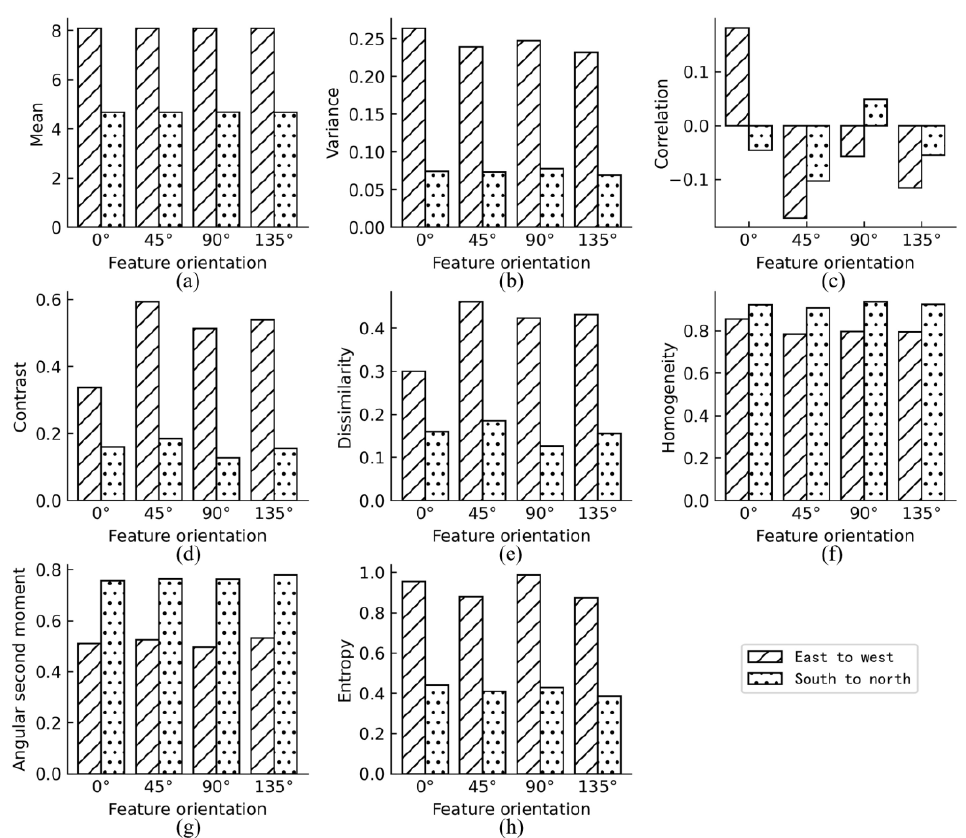
Figure 9. Textural features from the cropland with rowing from east to west and south to north. And ( a – h ) represent the textural features of mean, variance, correlation, contrast, dissimilarity, ho- mogeneity, angular second moment, and entropy, respectively.